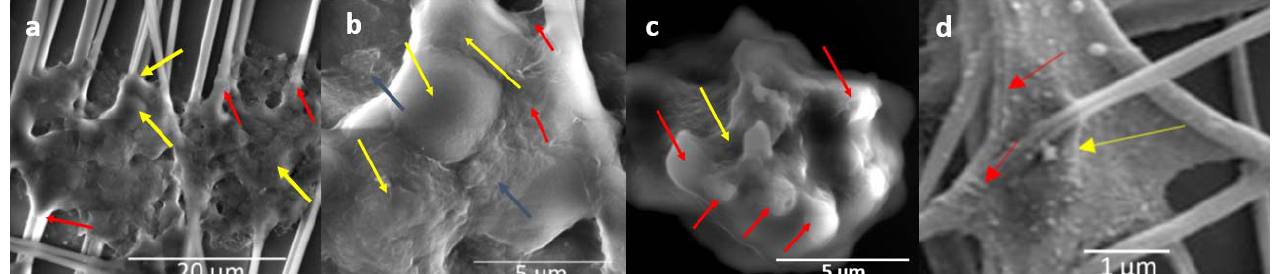
Figure 6. Environmental scanning electron microscopy of cultured BmVIII ‐ SCC cells adhering to PET nanofibers. ( a ) Fibrous ‐ like tissue attaching to individual nanofibers (red arrows) suggests the presence of an extracellular matrix (ECM); note the encased cells (yellow arrows) (3000X). ( b ) Dome ‐ like structures, presumably cells encased in ECM (yellow arrows), flat ‐ sheet morphology of ECM (dark olive arrows), cord ‐ like outer edge of ECM (red arrows) (10,000X). ( c ) Shallow groove (yellow arrow) suggests prior attachment of an enclosed spheroid (red arrows) to a synthetic nanofiber that was dislodged during fixation (10,000X). ( d ) Scanning electron micrograph of the mammalian alveolar cell, A645, in 3 ‐ D culture with PET nanofiber provided by Nanofiber Solutions, Inc. (Columbus, OH, USA). is shown for comparison exhibiting fibrous nature of the avian ‐ derived extracellular matrix (red arrows), and structural mass encased by the matrix (yellow arrow).